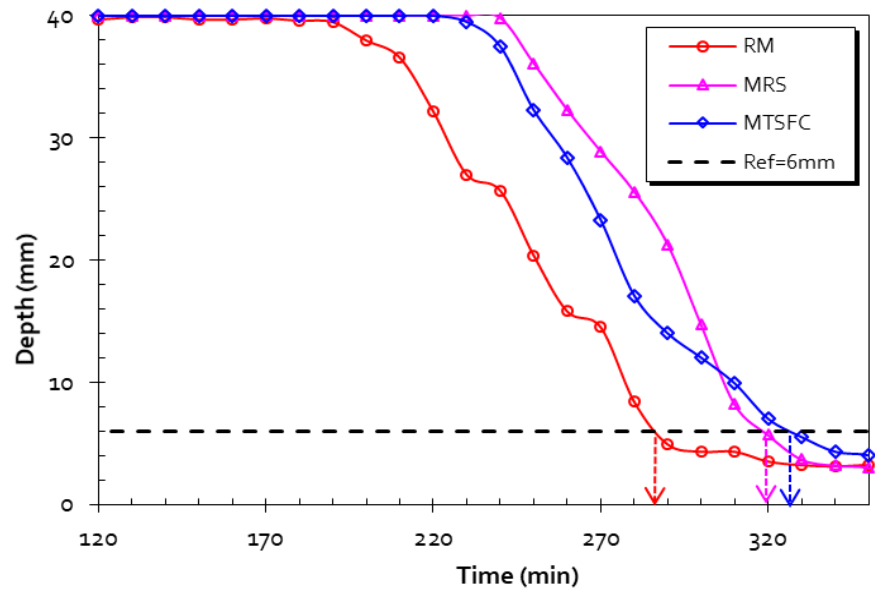
Figure 13. Evolution of the initial setting time for RM, MRS, and MSTFC.